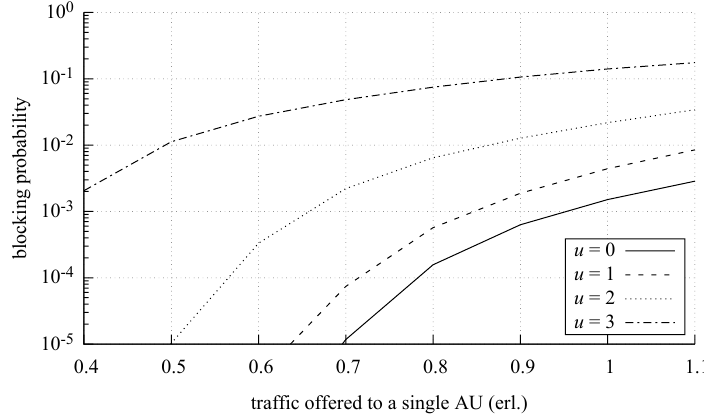
Figure 10. Blocking probability for class 1 calls in relation to the number of deactivated switches ( u